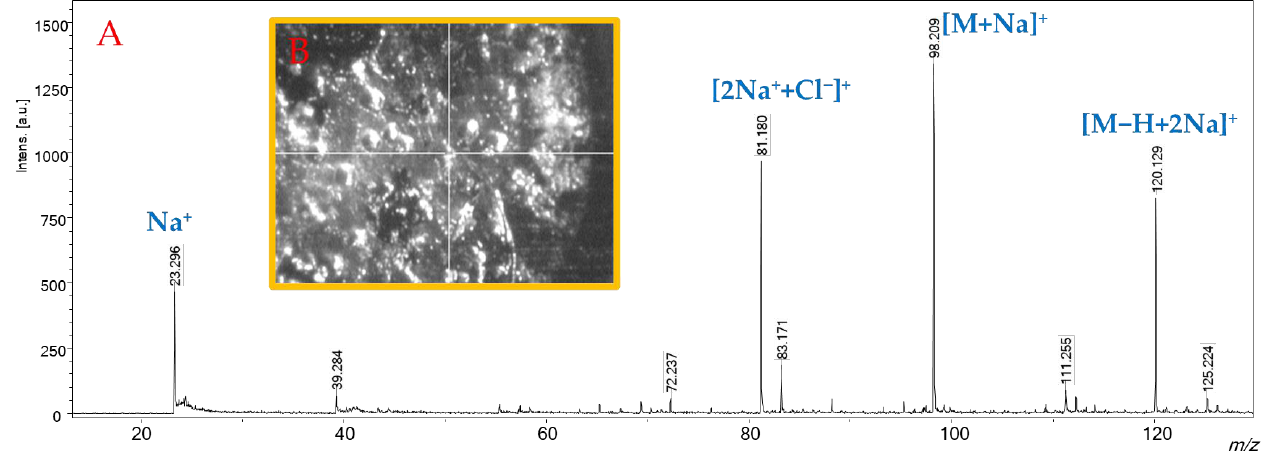
Figure 6. Panel ( A ): SALDI-MS spectrum, in positive ionization mode, of a water solution of glycine (1 mg/mL), obtained by treating SWCNHs with a 60 mmol/L solution of NaCl. Panel ( B ) : “Brilliant” structures on the SWCNH-based surface treated with a 60 mmol/L solution of NaCl captured by the instrumental camera.